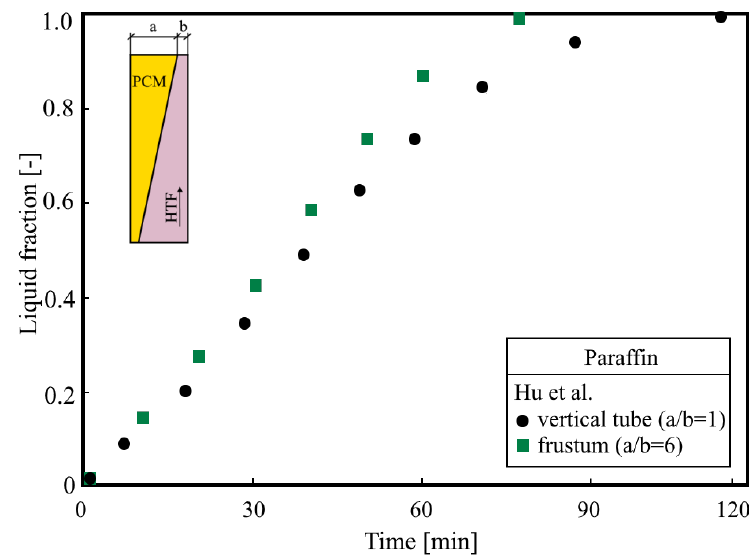
Figure 10. Influence of DTV shell shape on melting process [42].